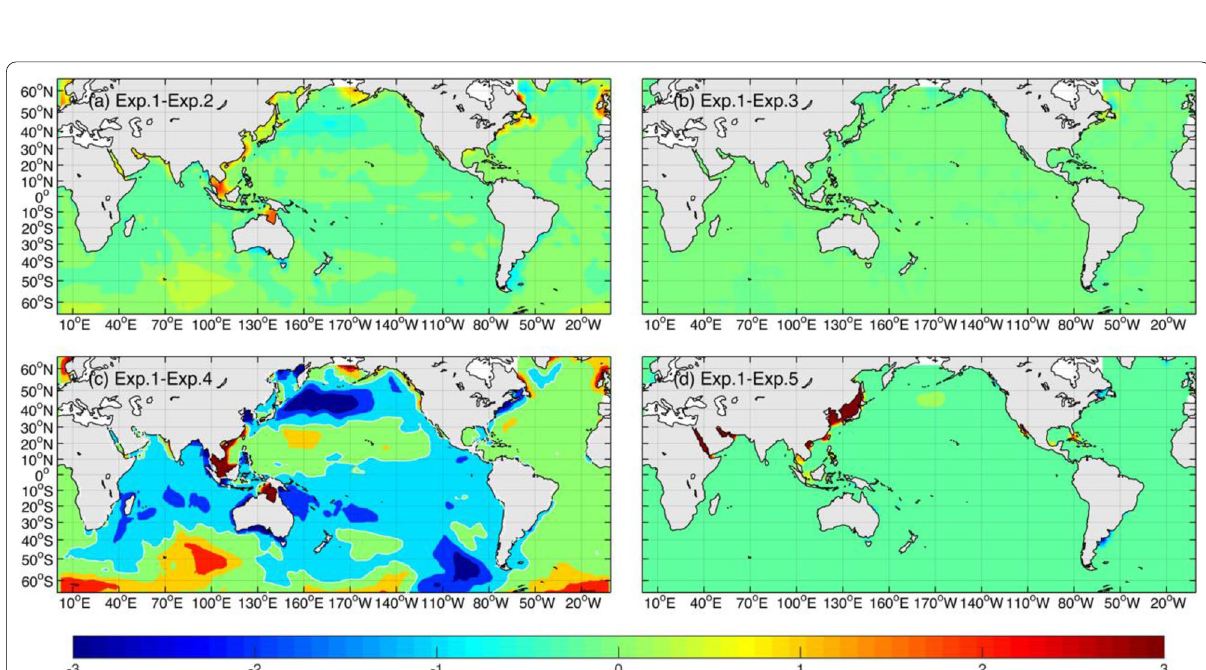
Fig. 6 Simulated ocean bottom pressure anomalies (cm) during boreal winter for a Exp. 1–Exp. 2, b Exp. 1–Exp. 3, c Exp. 1–Exp. 4 and d Exp. 1–Exp.